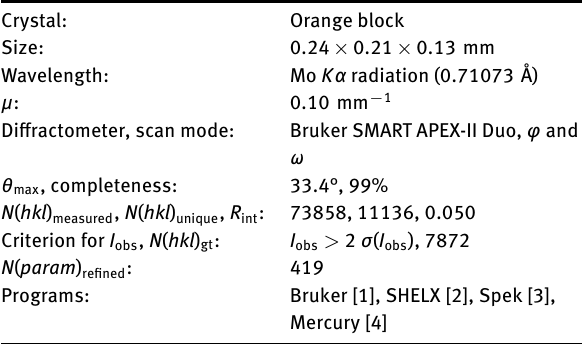
Table 1 contains crystallographic data and Table 2 contains the list of the atoms including atomic coordinates and dis- placement